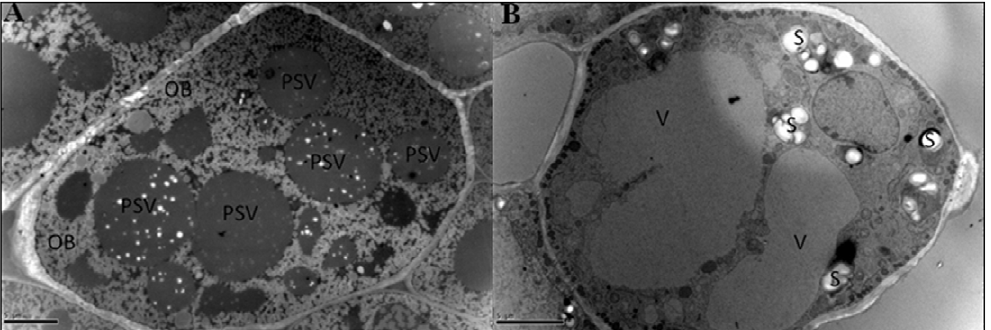
Figure 6. TEM images of soybean seeds showing the accumulation of starches at the late stage of soybean seed germination. (A) the dry seeds; (B) 3-day-imbibition seeds. PSV, protein stocking vesicle; OB, oil body; S, starch granule; V, vacuole. Bars’ lengths are 5 um.